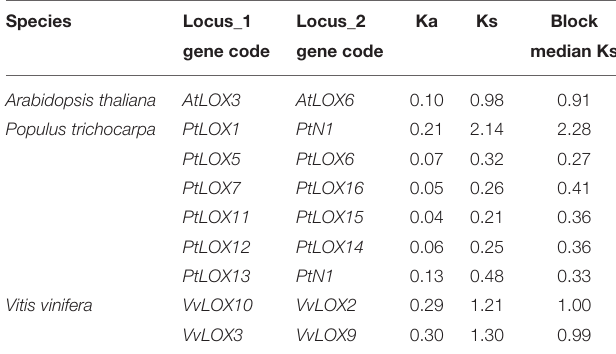
TABLE 2 | Median Ks values of SCB pairs associated with the expansion of LOXs within the genomes of each species.